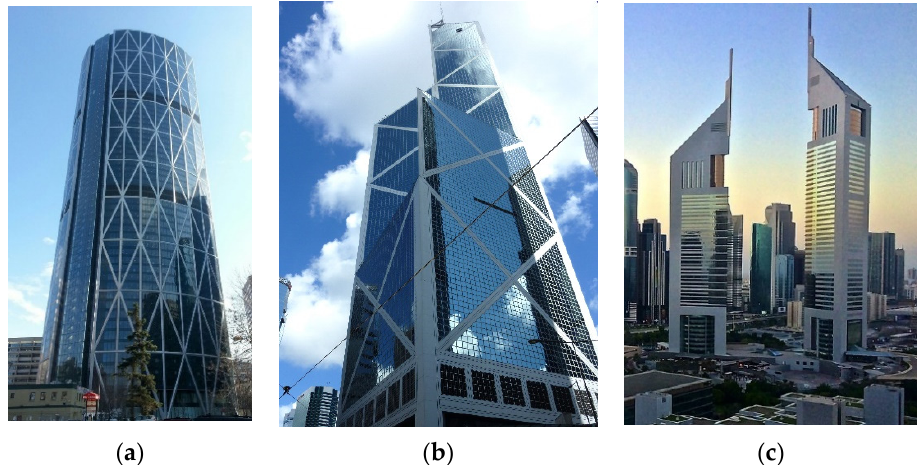
Figure 2. ( a ) The Bow—Calgary) [4]; ( b ) Bank of China Tower—Hong Kong [5]; ( c ) Emirates Towers—Dubai